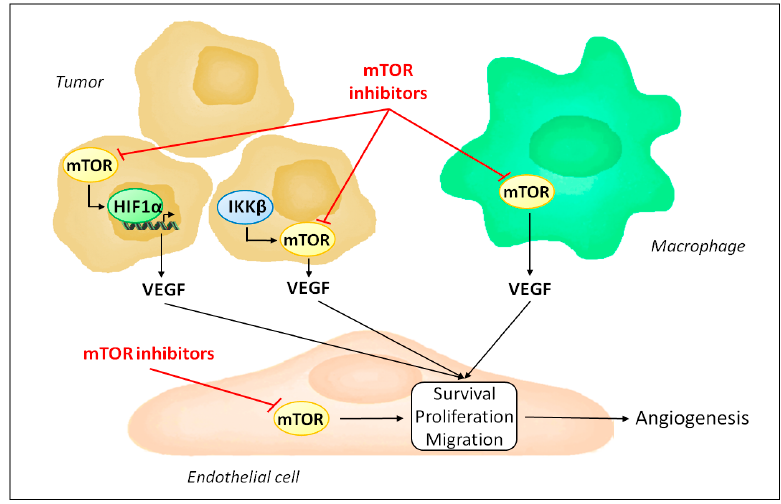
Figure 2. Mechanisms by which mTOR inhibitors affect tumor angiogenesis. mTOR inhibitors reduce endothelial cell proliferation, survival and migration by blocking endothelial mTOR. In addition, they decrease VEGF production, as mTORC1 is required to stabilize HIF1 α during the hypoxic tumor response and is activated by IKK β in inflammation-mediated angiogenesis. Finally, mTOR inhibitors induce tumor associated macrophage polarization to an anti-angiogenic phenotype.